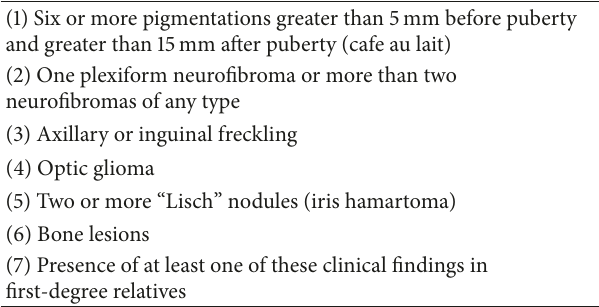
Figure 1: Neurofibromas and cafe au lait spots on the skin.